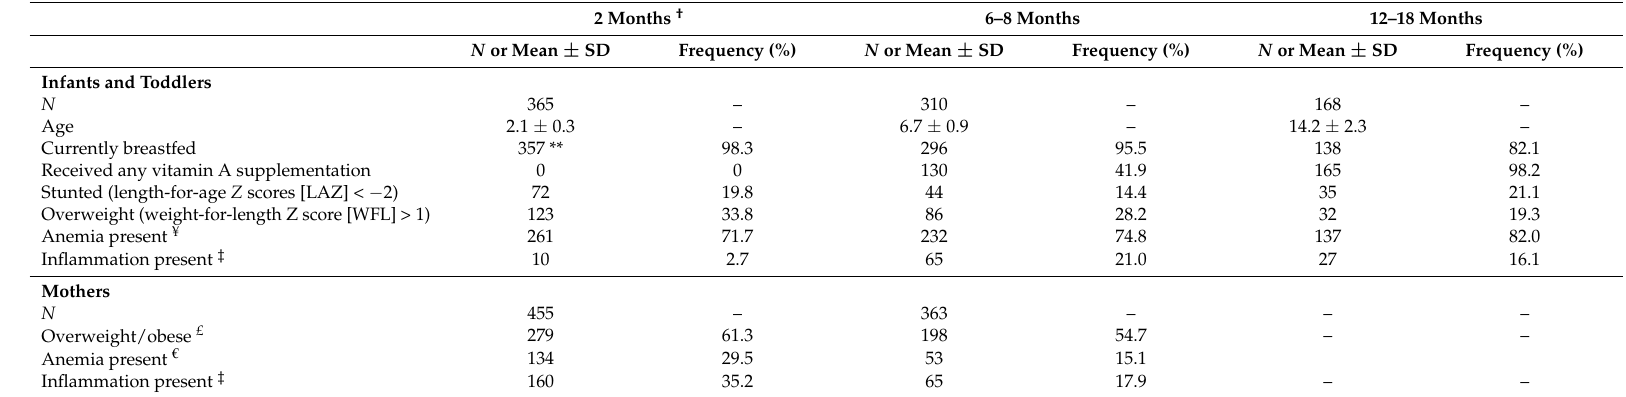
Table 2. Time-varying characteristics of the study population